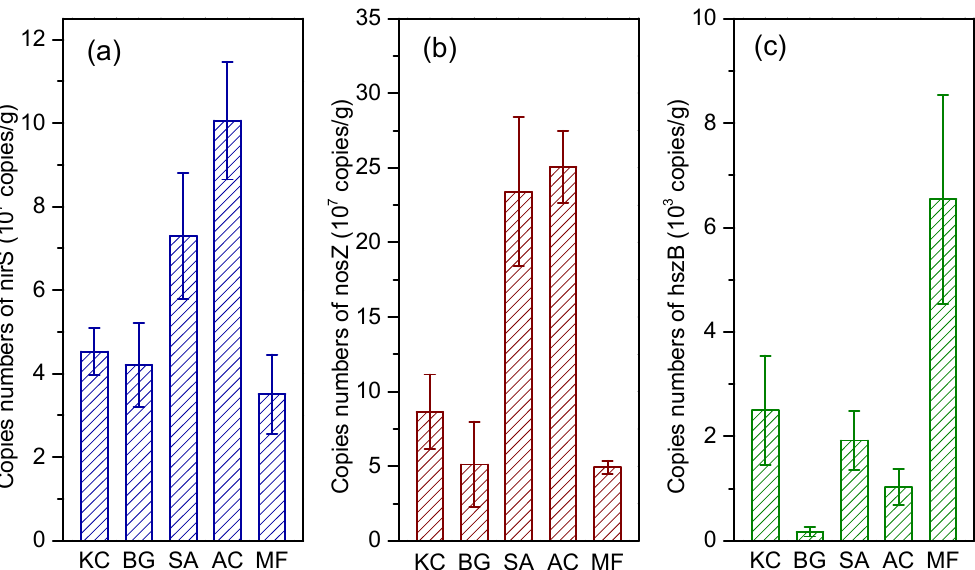
Figure 5. Copy numbers of nir S ( a ), nos Z ( b ), hzs B ( c ) at five sites. KC, BG, SA, AC, and MF are site abbreviations for Kandelia candel , Bruguiear gymnorrhiza , Sonneratia apetala , Aegiceras corniculatum , and mud flats, respectively.